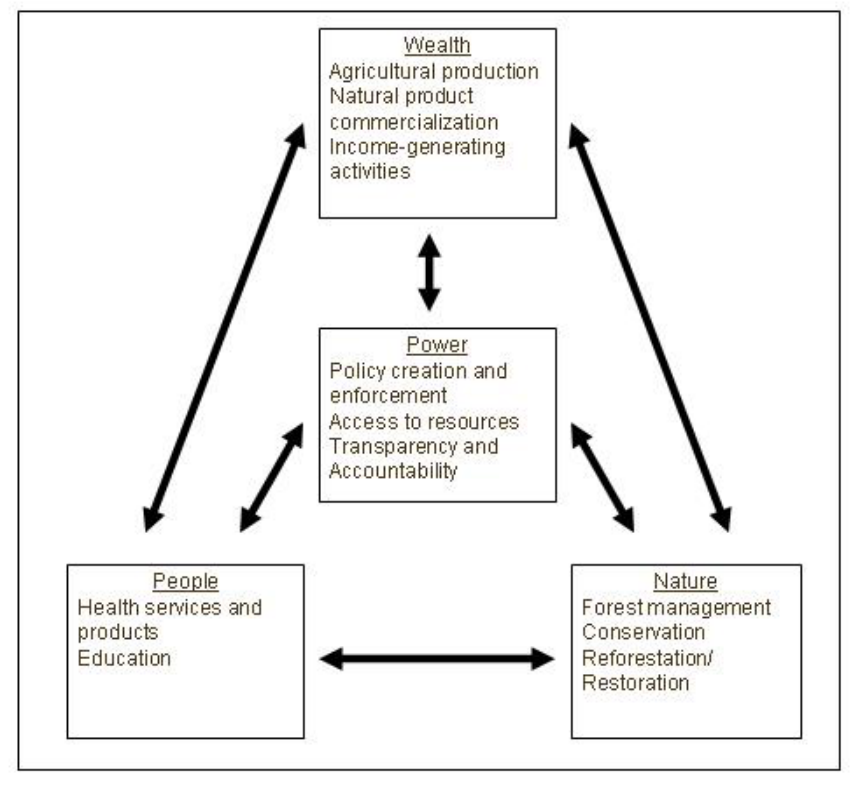
Fig. 1 . People, Nature, Wealth, and Power provides a conceptual framework to guide the assessment of the responsiveness of community-based forest management efforts to local